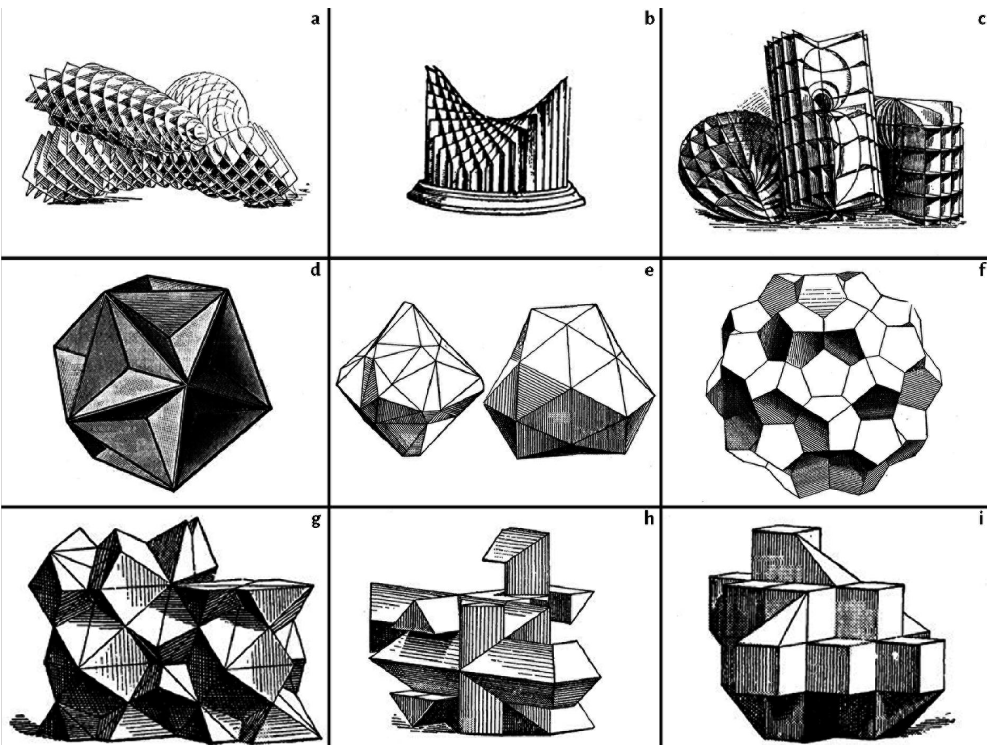
Fig. 1 Models from